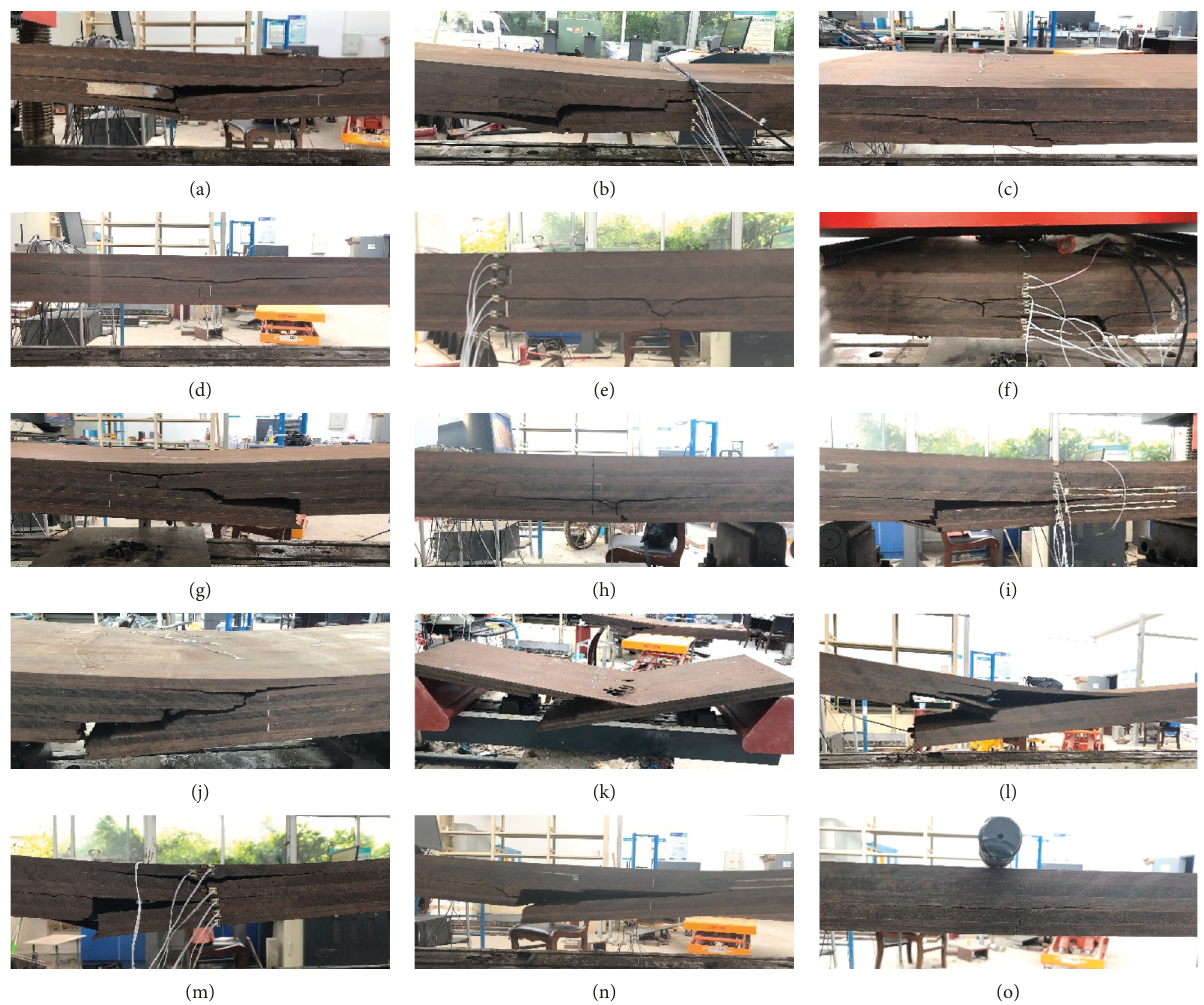
Figure 14: Failure modes of groups CLB-A, CLB-B, and CLB-C. (a) CLB-A1. (b) CLB-A2. (c) CLB-A3. (d) CLB-A4. (e) CLB-A5. (f) CLB- B1. (g) CLB-B2. (h) CLB-B3. (i) CLB-B4. (j) CLB-B5. (k) CLB-C1. (l) CLB-C2. (m) CLB-C3. (n) CLB-C4. (o)